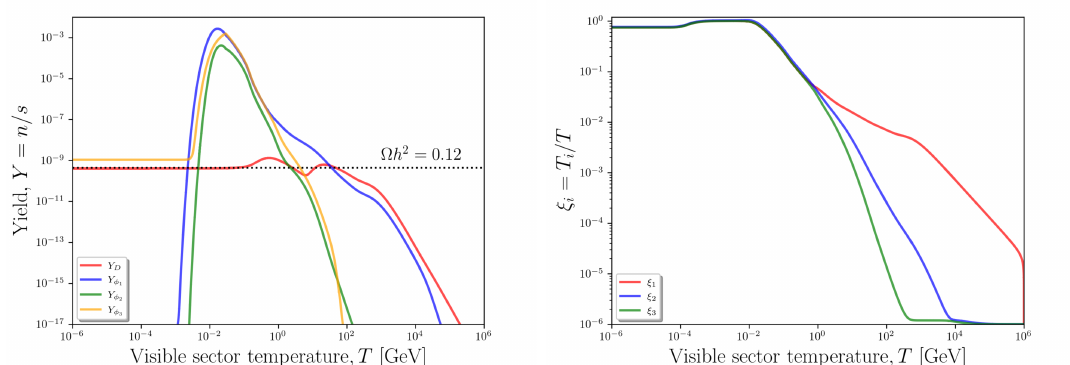
Figure 5. The case of three initially cold dark sectors. Left panel: evolution of the yields of the dark fermion D and of the spin zero particles of the dark sector versus the visible sector temperature. Right panel: evolution of the temperature ratios ξ i . The input parameters are: m D = 1 . 0 GeV, m φ = 50 MeV, m φ = 105 MeV, m φ = 45 MeV, y f = 1 × 10 − 9 , y D = 0 . 05 , κ 1 = 10 − 7 1 2 3